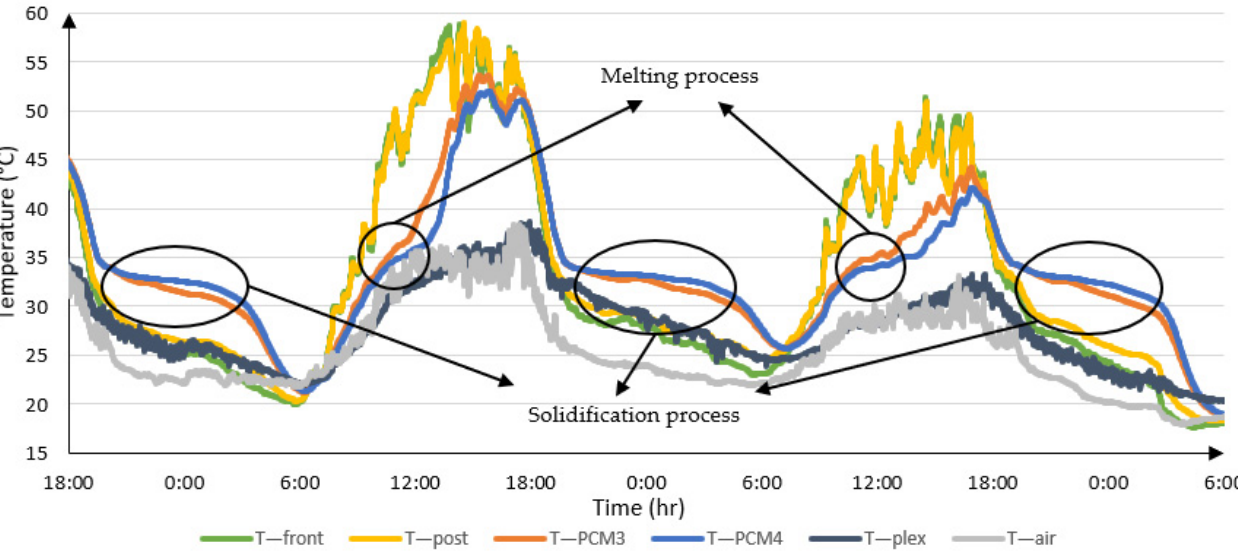
Figure 16. Monitoring of temperatures of the enhanced panel during the outdoor test.